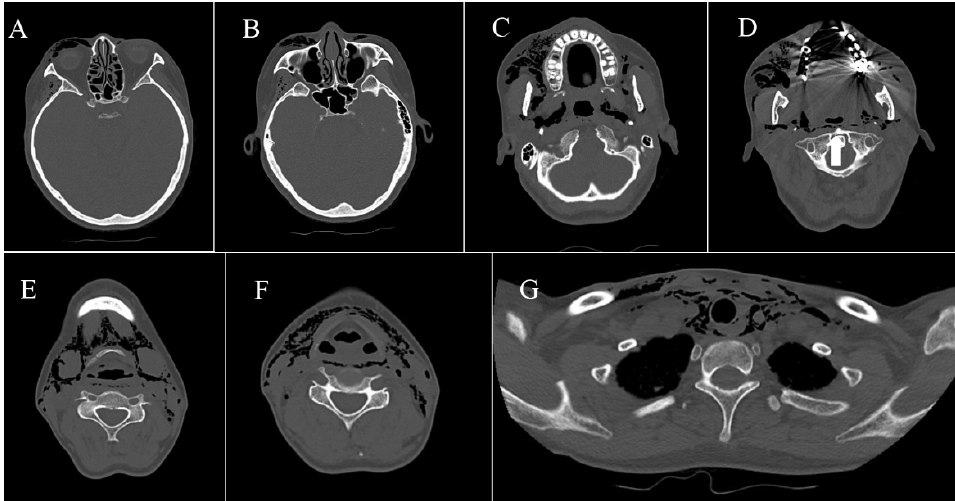
Figure 4. ( A ) Air was noted in the orbital soft tissue. ( B ) Air was noted in the buccal space. ( C ) Air